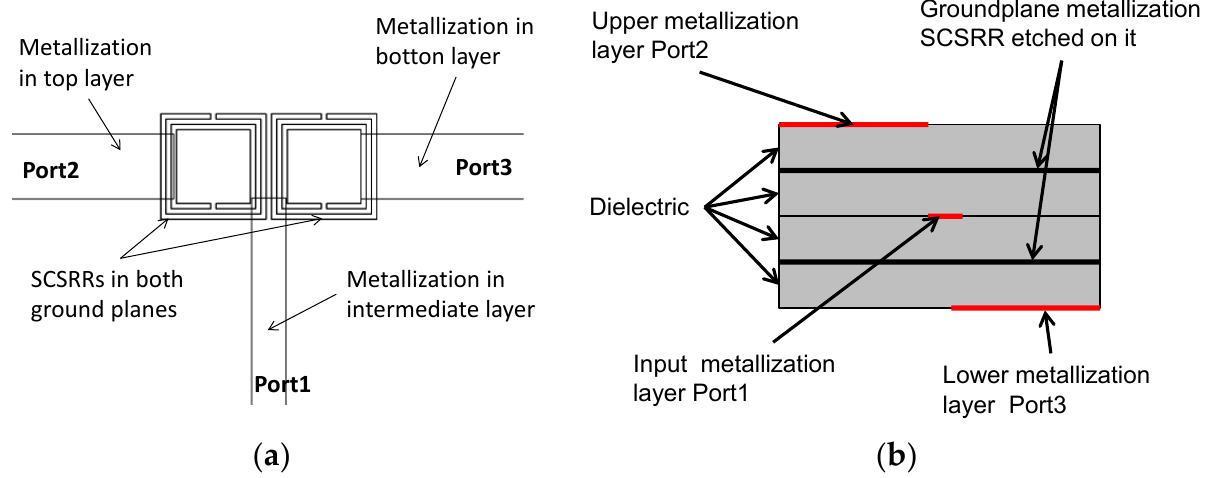
Figure 22. ( a ) Top view of the overlapped layer distribution of a two-layer duplexer. ( b ) Front view of the layer distribution.